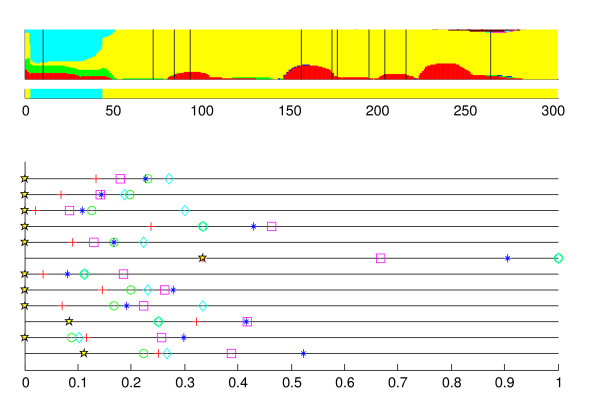
Coalescent strain #15. The results for the strain #15 in the coalescent simulation.